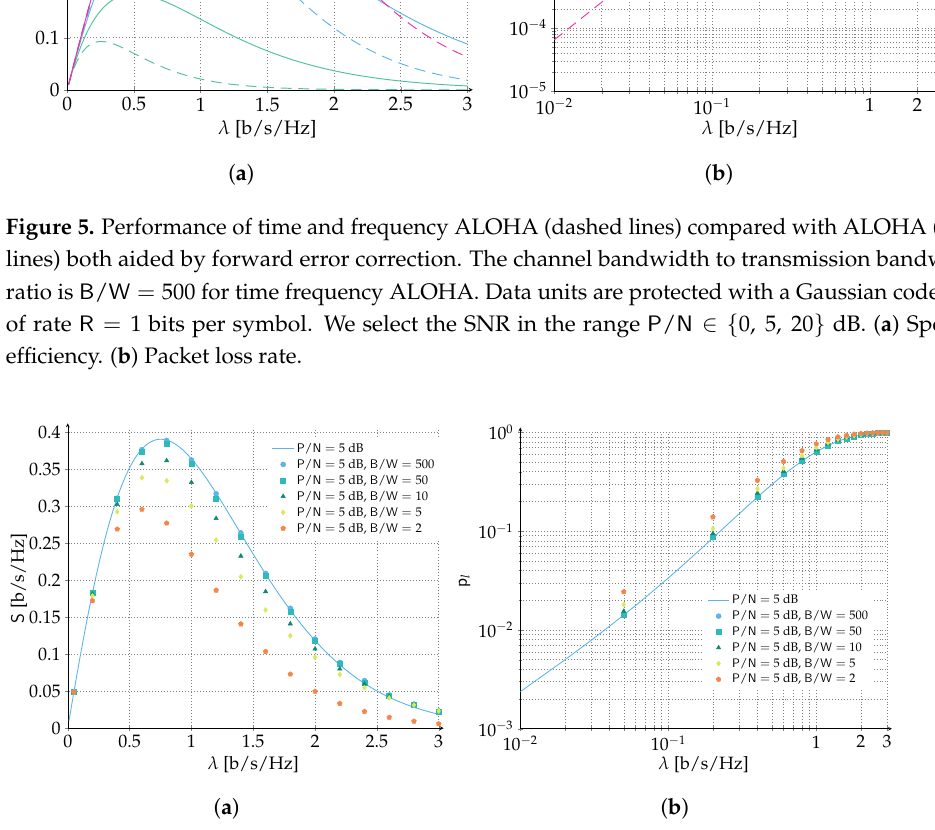
Figure 6. Performance of time and frequency ALOHA aided by forward error correction for various channel bandwidth to transmission bandwidth ratios. The channel bandwidth to transmission bandwidth ratio is in the range B / W = 500,50,10,5,2 . Data units are protected with a Gaussian codebook of { } rate R = 1 bits per symbol. We select the SNR of P / N = 5 dB. Similar trends have been observed also for other values of SNR not reported in the figure. ( a ) Spectral efficiency. ( b ) Packet loss